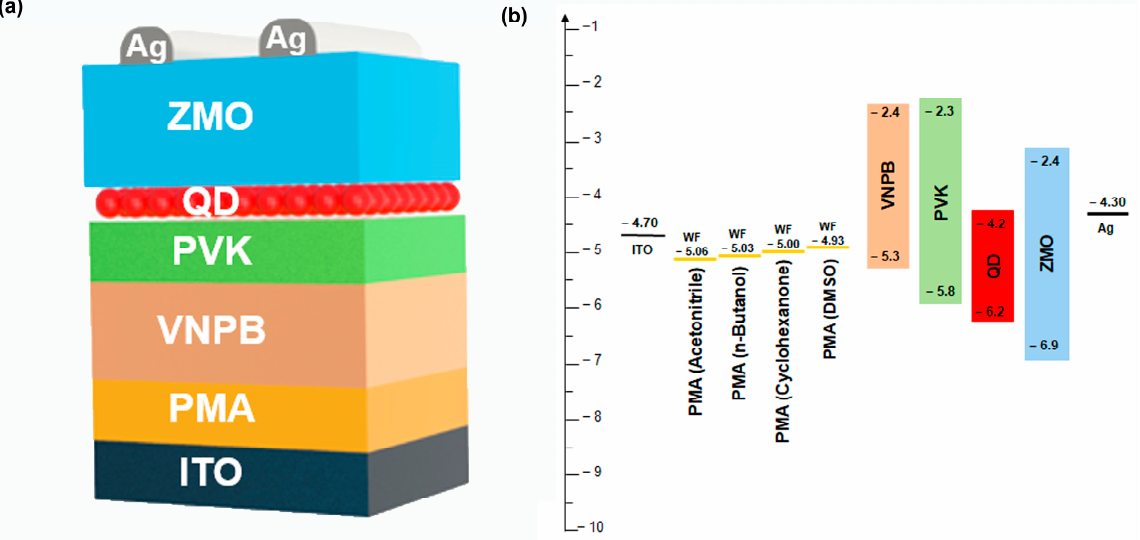
Figure 5. ( a ) Structure of QD-EL device and ( b ) energy band diagram using PMA as HIL with various solvents.